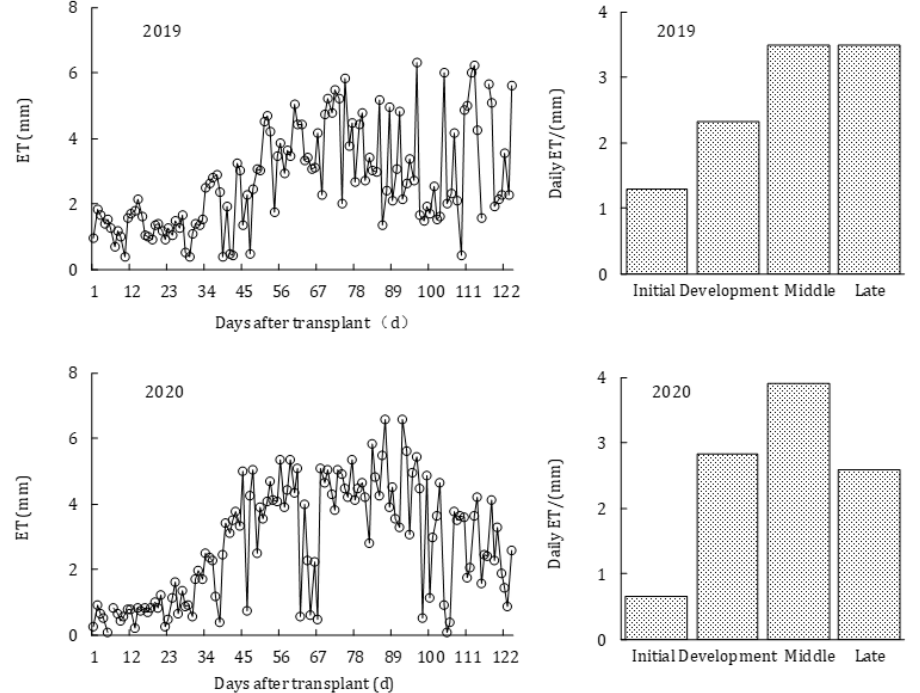
Figure 3. Variations of ET over the whole growth period and daily average ET at four growth stages in 2019 and